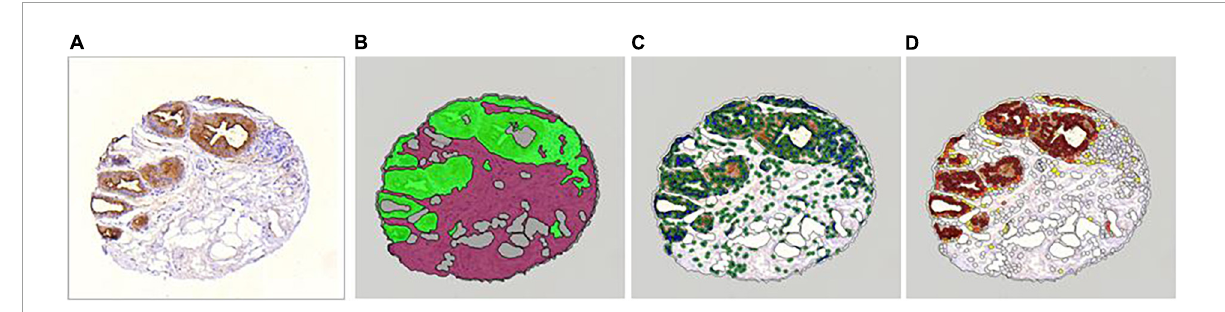
FIGURE1 Definiens workflow (This example core was manually read as > 50% in epithelium and 1–10% in stroma). (A) Raw core. (B) Automated tissue segmentation (epithelium in green, stroma in magenta). (C) Automated cell detection using nuclei (detected nuclei are circled in green). (D) Automated cell scoring (cells with brown chromogen are highlighted with yellow, orange, and brown overlay to reflect chromogen intensity).